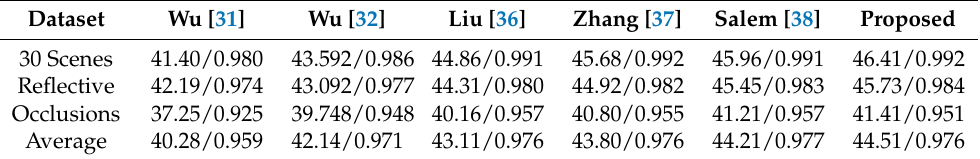
Table 1. The proposed model’s numerical comparison (PSNR/SSIM) model to reconstruct 7 × 7 out of 3 × 3